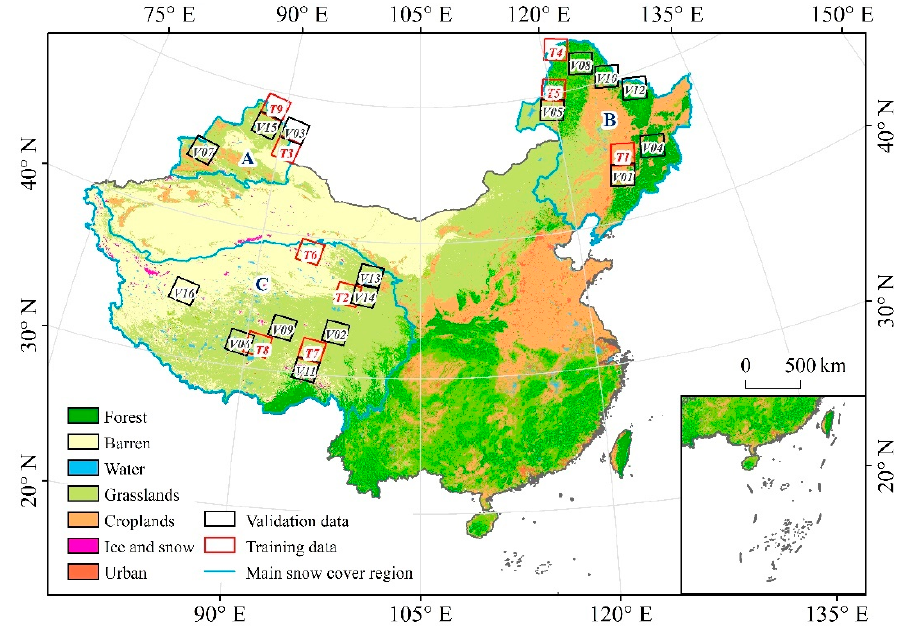
Figure 1. The study area and spatial distribution of training and validation images of Landsat 8 that were selected in three main snow cover regions of China (A: northwestern China, B: northeastern China, C: Qinghai–Tibet Plateau).